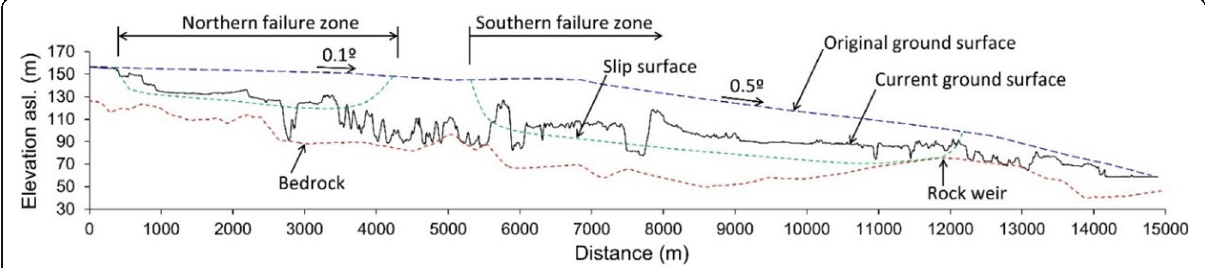
Fig. 5 Longitudinal section of Quyon landslide (vertical exaggeration: